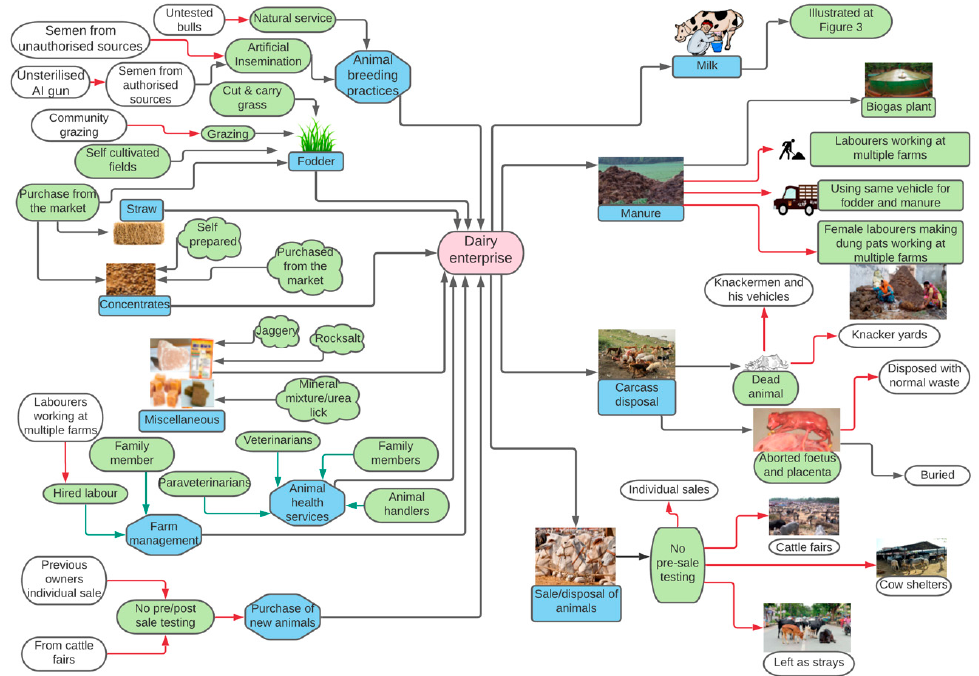
Figure 2. Overview of dairy input and output value chains created based on seven focus group discussions (FGDs) and five key-informant interviews (KIIs) conducted with 119 stakeholders in the Punjab state of India, 2018–2019. Green and red arrows indicate low and high risk for disease transmission,